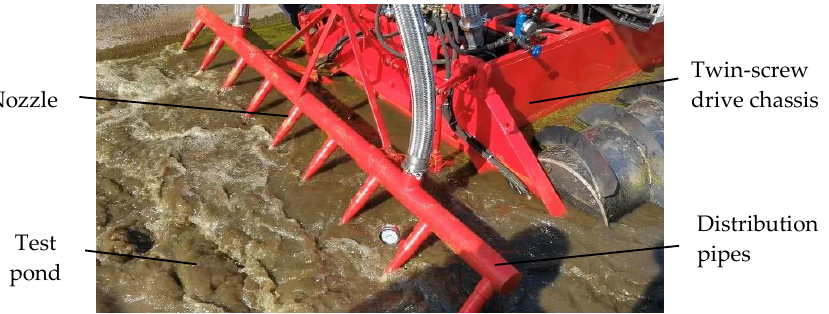
Figure 12. The hydraulic scouring lotus root harvest test.